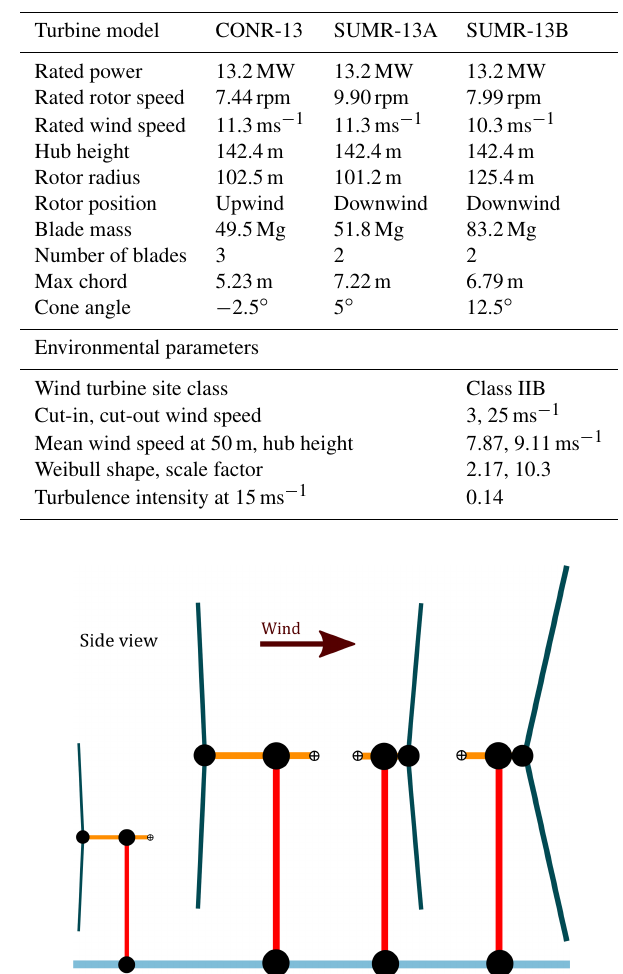
Table 1. Turbine models and environmental parameters used throughout this article.